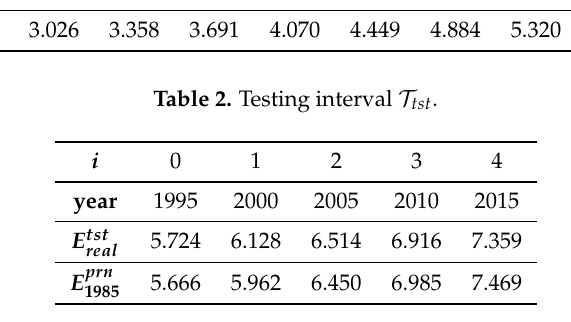
Table 3. Forecasting interval T frc